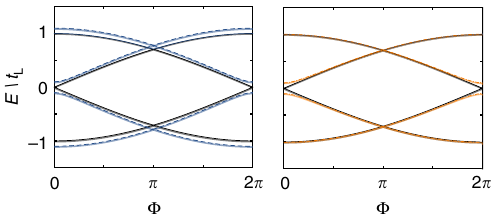
Figure 2 | Energy spectrum of the model. The energy spectrum of the minimal model in equation (2) with different parameters, with the width of the lines indicating the deviation from the energy spectrum of the full microscopic model (shifted by an energy constant to lie at the same scale) in equation (1) with ( N ¼ 10, D ¼ t ¼ 10 t L , m ¼ 0). Left panel: t R ¼ t L , m 0 ¼ 0 (black, solid), t R ¼ 1.2 t L , m 0 ¼ 0 (blue, dash). Right panel: t R ¼ t L , m 0 ¼ 0 (black, solid), t R ¼ t L , m 0 ¼ 0.2 t L (orange, dot dash). Despite the 4 p periodicity of the Hamiltonian, adiabatically following the ground state of the spectrum results in an 8 p periodic pattern. The degeneracies at F ¼ p are protected by the global Z 2 parity symmetry, while the degeneracies at F ¼ 0 are present for t L (cid:2) t R ¼ m 0 crossings in Fig. 2, we first focus on the symmetric case t L ¼ t R . At t L F ¼ 0, we have H g g ð g (cid:2) g Þ , that is, the four Majorana J 0 ð Þ¼ L x R y 2 i operators form two disjoint pairs giving rise to two single-particle (cid:8) (cid:2) t L (hole) excitations with energy t L 2 2